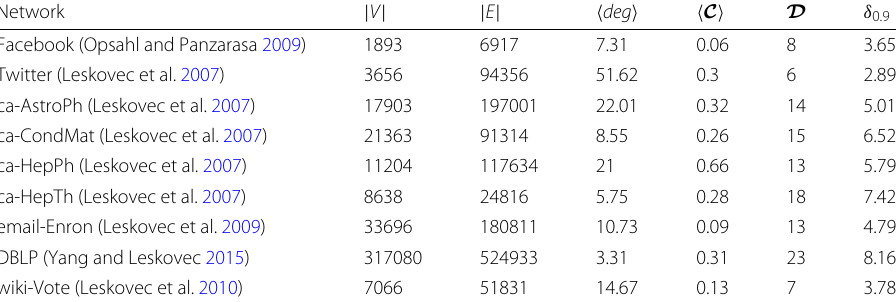
Table 1. The four notations (cid:13) deg (cid:14) , (cid:13) C (cid:14) , D , and δ 0.9 represent the “average degree”, “average clustering coefficient”, “network diameter”, and “90-percentile effective diameter”, respec- tively. In the case of a disconnected network, we extracted the largest (strongly) connected